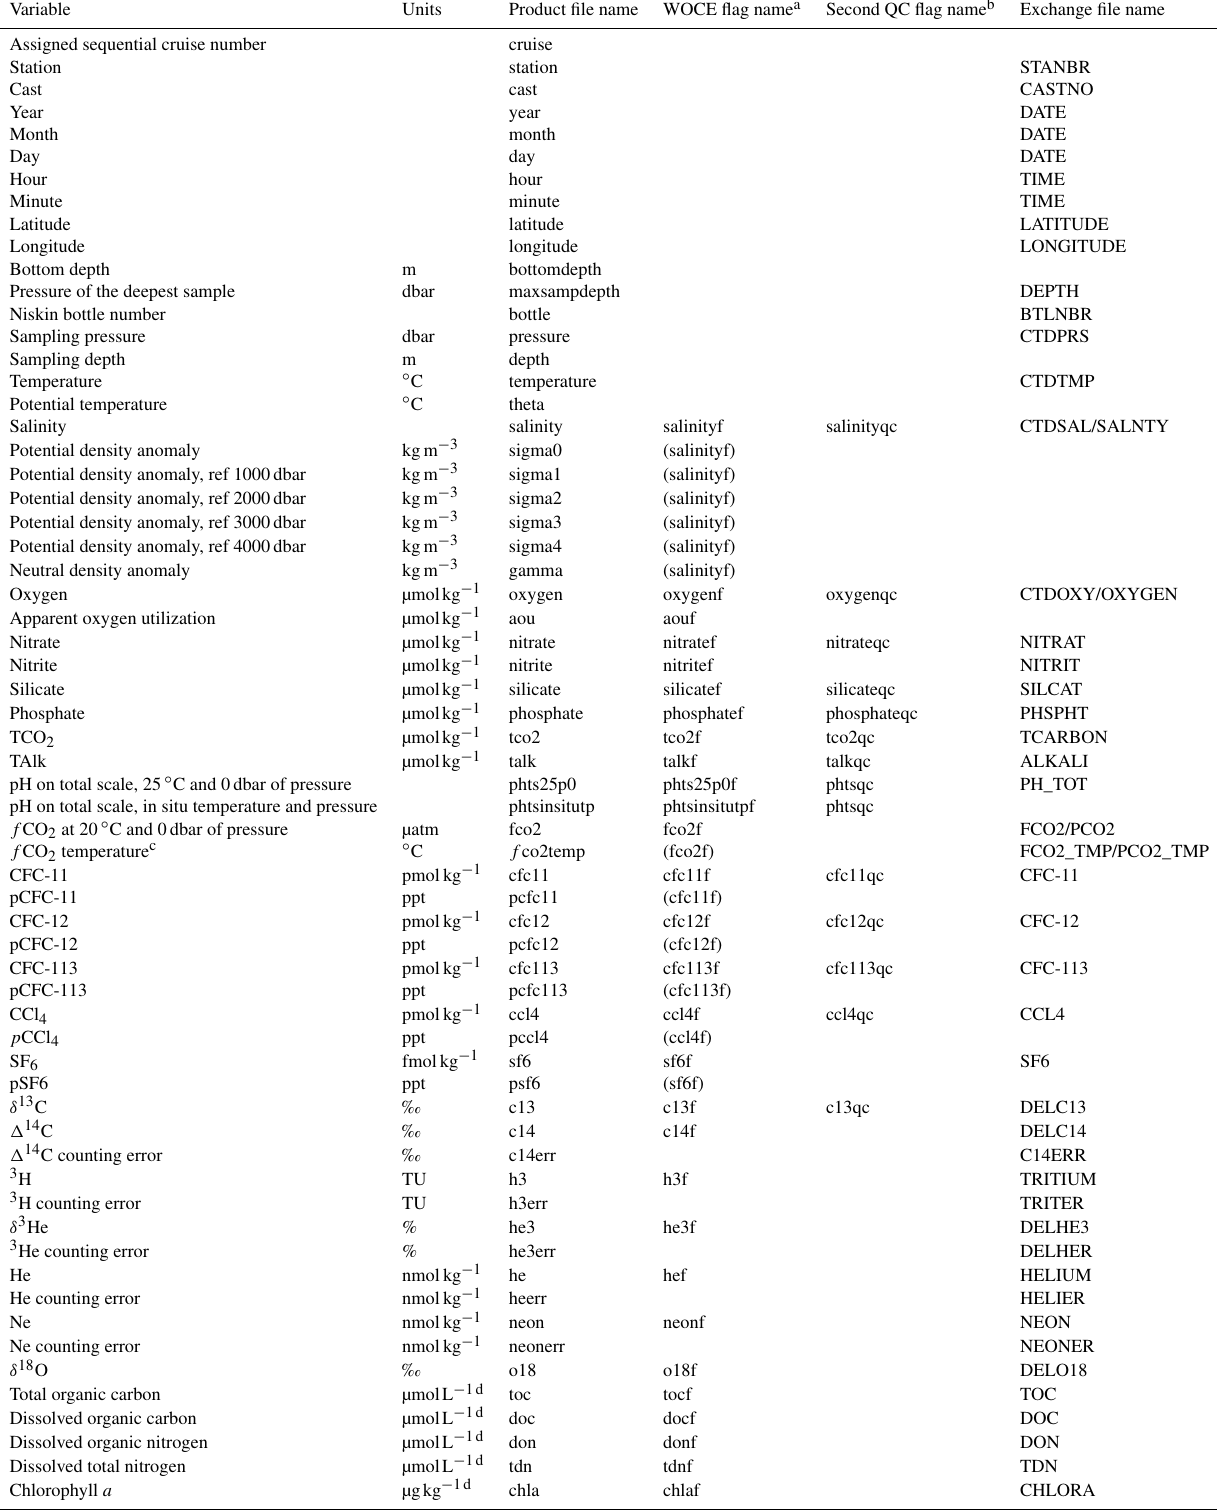
Table 1. Variables in the GLODAPv2.2020 comma-separated (csv) product files, their units, short and flag names, and corresponding names in the individual cruise exchange files. In the MATLAB product files that are also supplied a “G2” has been added to every variable name.